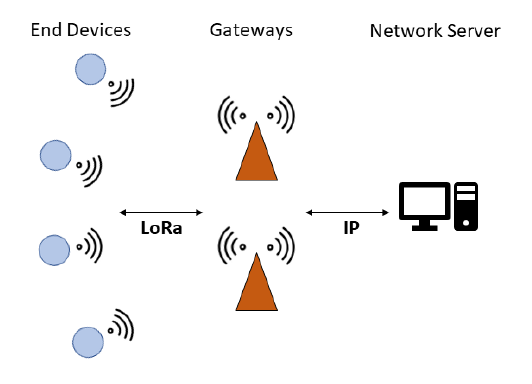
Figure 1. LoRaWAN network architecture.